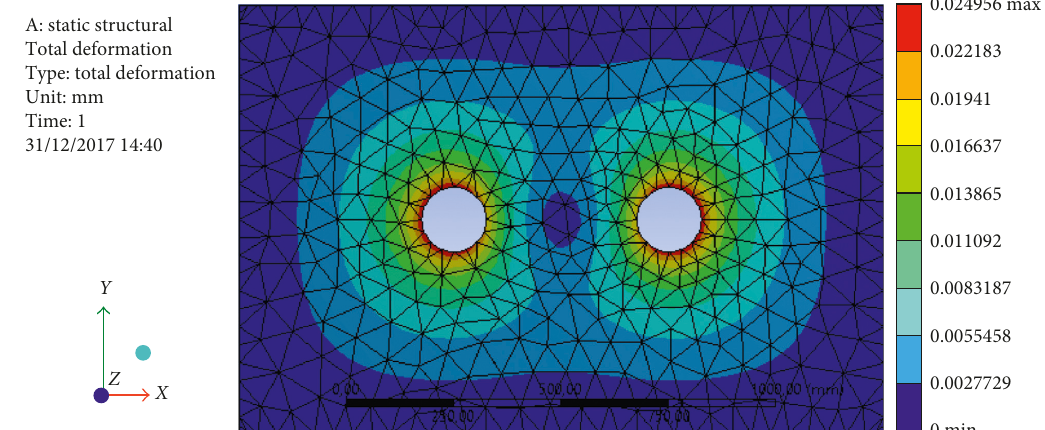
Figure 7: Redistribution of